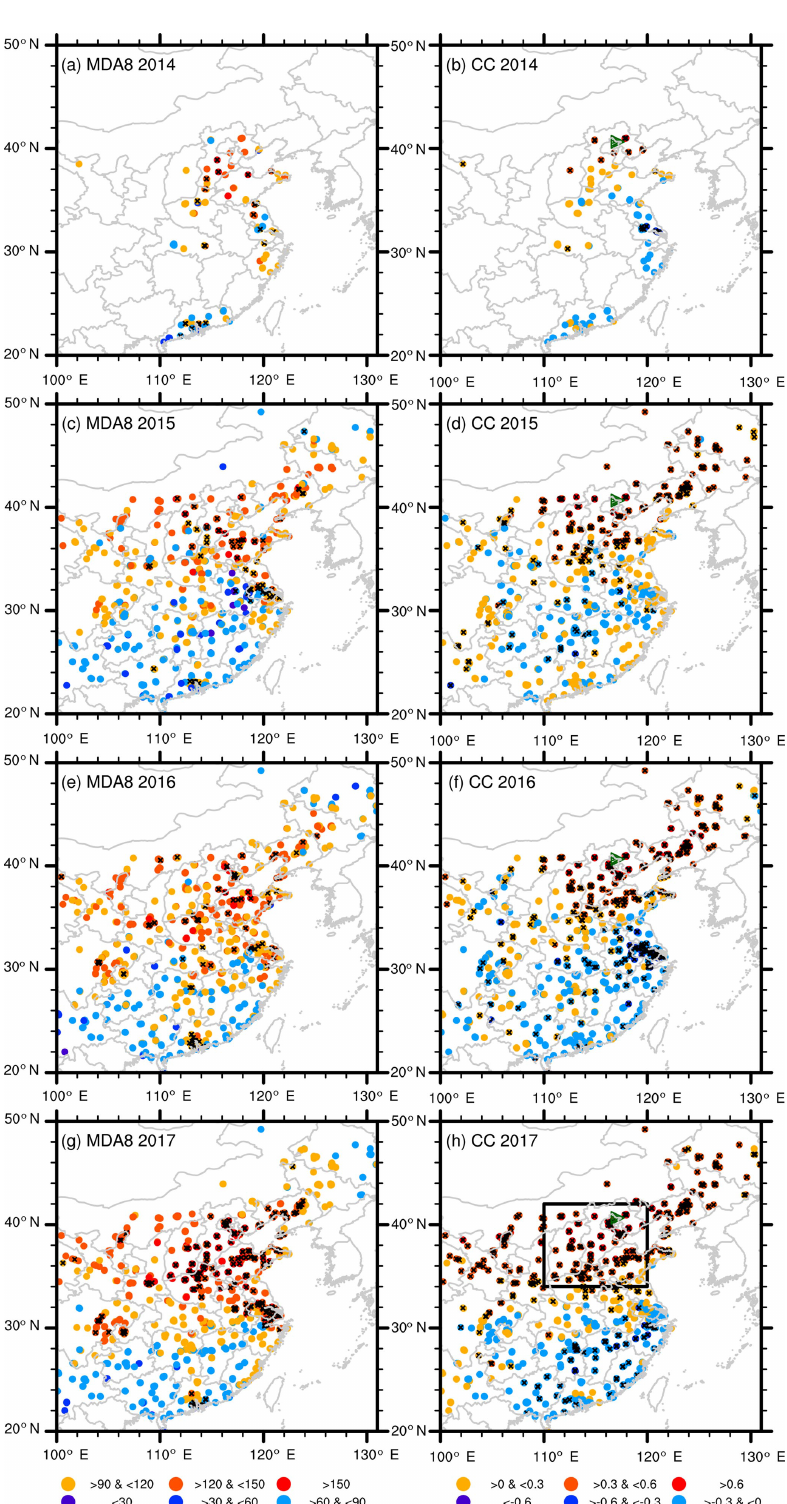
Figure 1. The distribution of the JJA mean MDA8 (a, c, e, g) and the correlation coefficients (b, d, f, h) between the daily MDA8 and SDZ MDA8 from 2014 to 2017. The black crosses in (a, c, e, g) indicate that the maximum daily MDA8 was larger than 265µgm − 3 . The black crosses (b, d, f, h) indicate that the correlation coefficient (CC) was above the 95% confidence level. The green triangle in (b, d, f, h) illustrates the location of the Shangdianzi site. The black box in (h) is the location of North